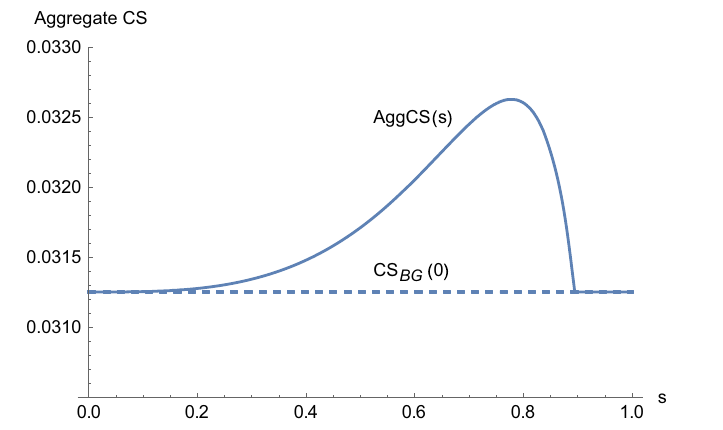
Fig. 6 Changes in aggregate consumer surplus as a function of changes in the size of the buyer group,